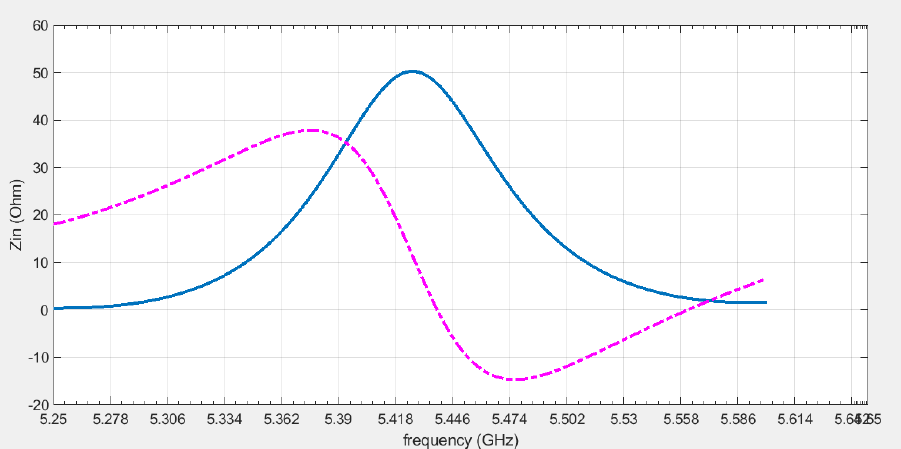
Figure 5: Return loss versus frequency calculated by FDTD method.